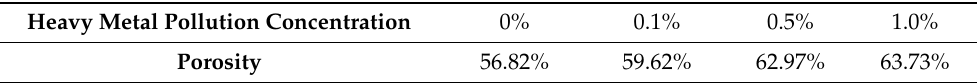
Table 2. Porosity of Pb 2+ -contaminated Guilin red